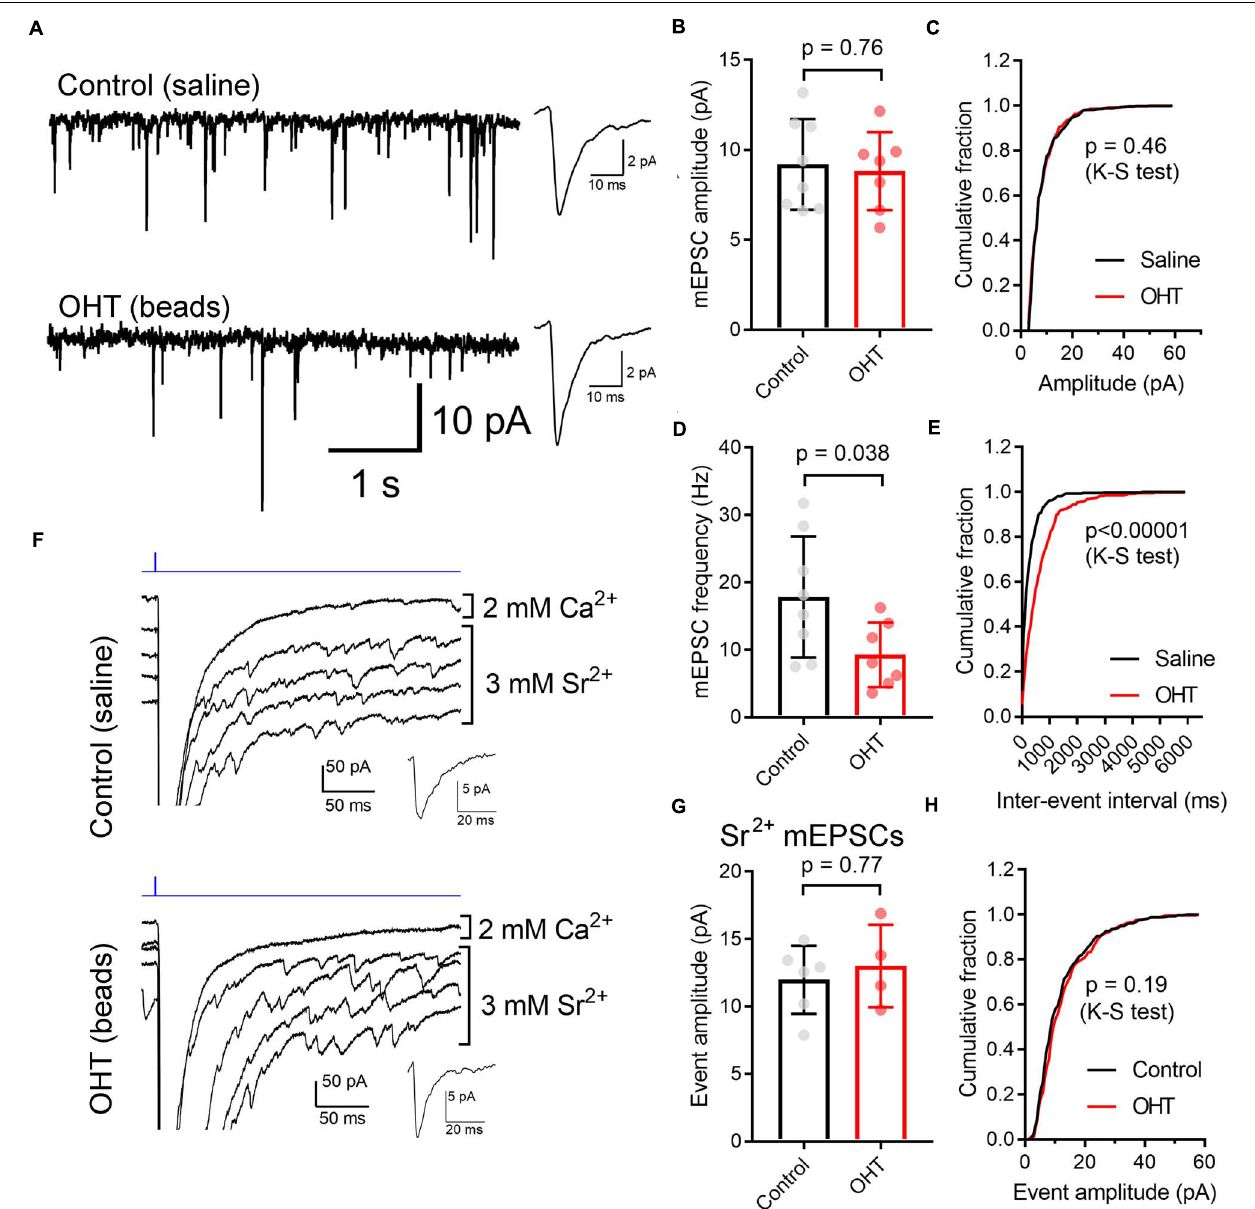
FIGURE 7 | Influence of OHT on single-vesicle synaptic currents in TC neurons in the dLGN. (A) mEPSCs recorded in the dLGN of TC cells in the absence of stimulation. These TC cells displayed evoked multiquantal EPSCs in response to ChR2 stimulation with 460 nm stimulation. Insets show mean mEPSC waveforms 100 individual mEPSCs detected in these recordings. (B,C) The mEPSC amplitude was not significantly different between control and OHT TC neurons. (D,E) The mEPSC frequency was significantly lower in OHT recordings whether assessed with an unpaired t -test (D) or with a Komolgorov–Smirnov test used to compare the cumulative distributions of 100 mEPSC inter-event intervals per recorded cell (E) . (F) To record properties of single-vesicle events evoked by ChR2 stimulation, CaCl 2 in the aCSF was replaced with 3 mM SrCl 2 . A single trace recorded in with Ca 2 + and four traces recorded with Sr 2 + are shown. Insets show waveforms of detected mEPSC events. (G,H) The amplitude of single-vesicle events evoked by ChR2 stimulation in Sr 2 + -containing aCSF were not significantly different between recordings from control and OHT mice. Values are plotted from individual cells in panels (B,D,G) and the bar graphs show mean + standard